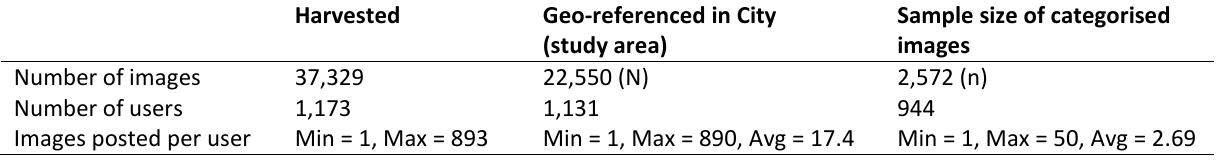
Table 1 . Basic description of Instagram images, number of users who have shared the images (i.e. Instagram users), and the range of images per user in the original, geo-referenced, and final sample of categorised